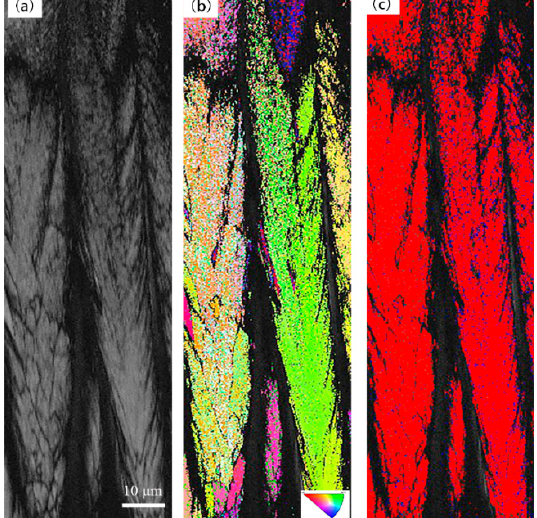
Figure 6. EBSD images of TBC YSZ-2: ( a ) quality maps; ( b ) orientation maps; ( c ) phase maps; The orientations are defined by tetragonal lattice symmetry.